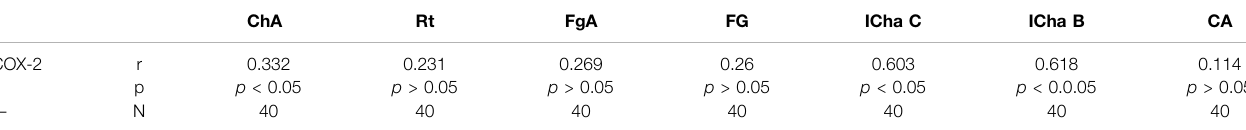
TABLE 4 | Biological activity and chemical composition content correlation analysis.